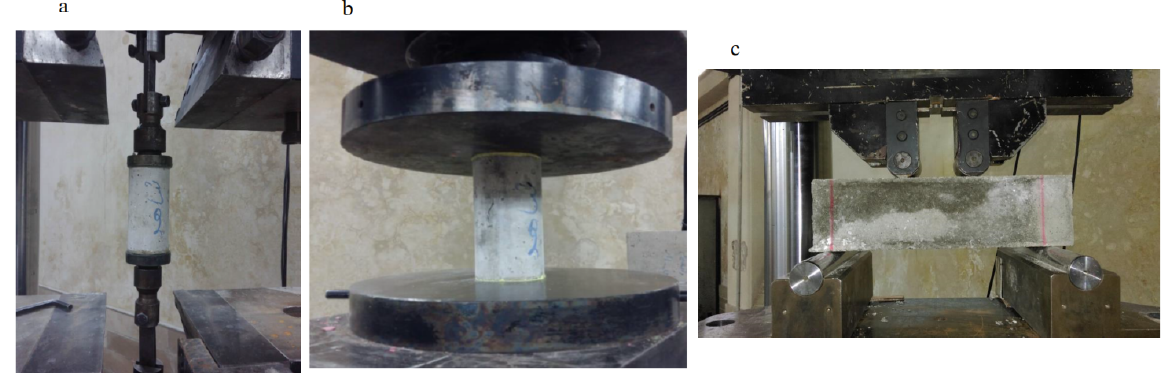
Figure 3: Testing procedure for different conducted tests in this study a. uniaxial direct tensile test; b. uniaxial compressive test; c. four- point loading